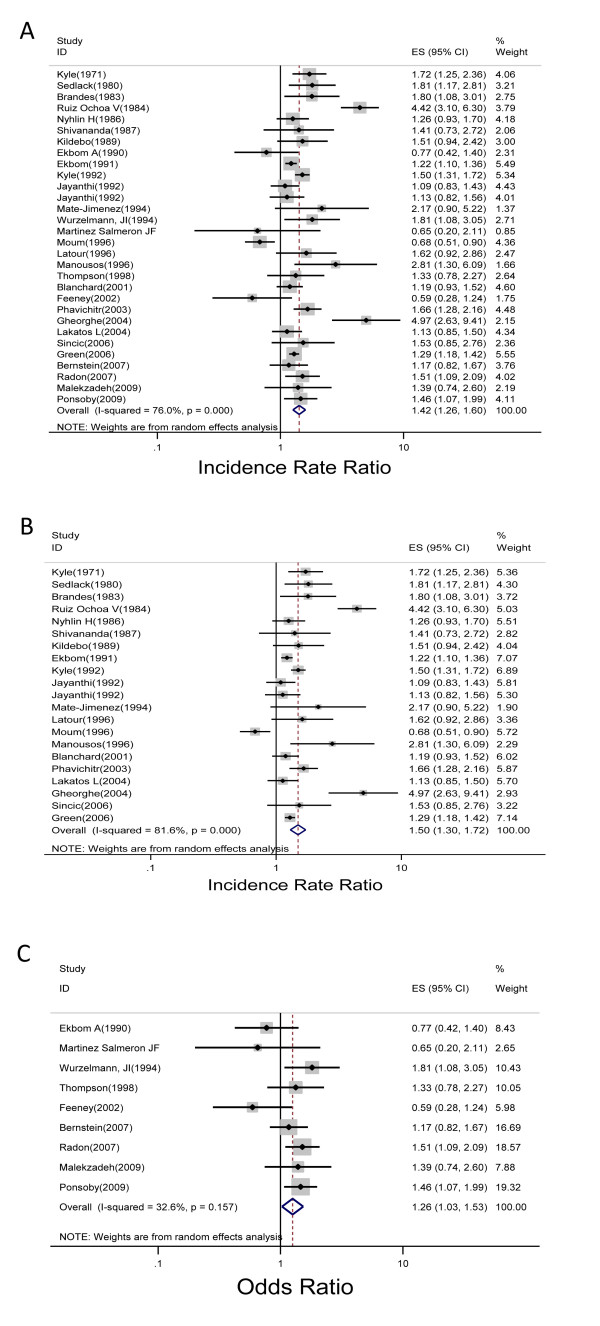
Forest plot of the summary effect estimate with 95% CI studies that explored the relationship between urban environment and Crohn’s disease for both cohort and case–control studies (A); cohort studies (B); and case–control studies (C).